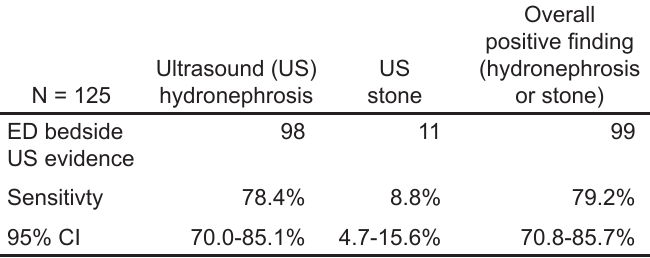
Table 2 . Sensitivity of ultrasound in all